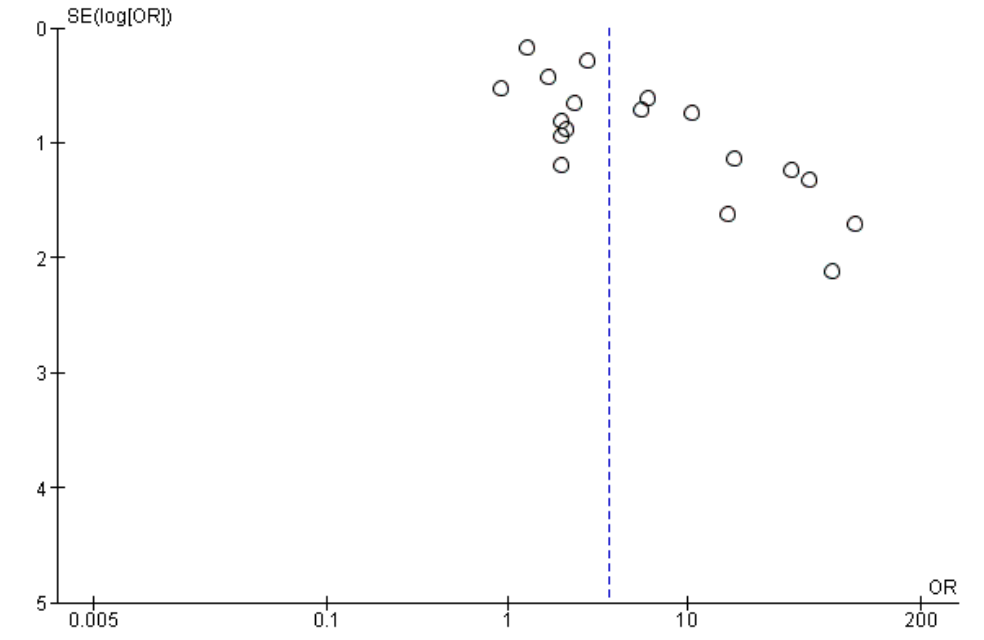
Figure 3. Funnel plot of 18 studies, including evaluating the risk of hepatobiliary tract malignancies according to the presence or absence of Helicobacter spp. infection detected by direct microbiological methods using a random ‐ effects model.